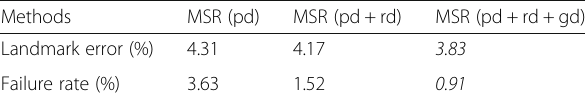
Table 3 Landmark errors and failure rates compared with different features of the MSR method on HELEN